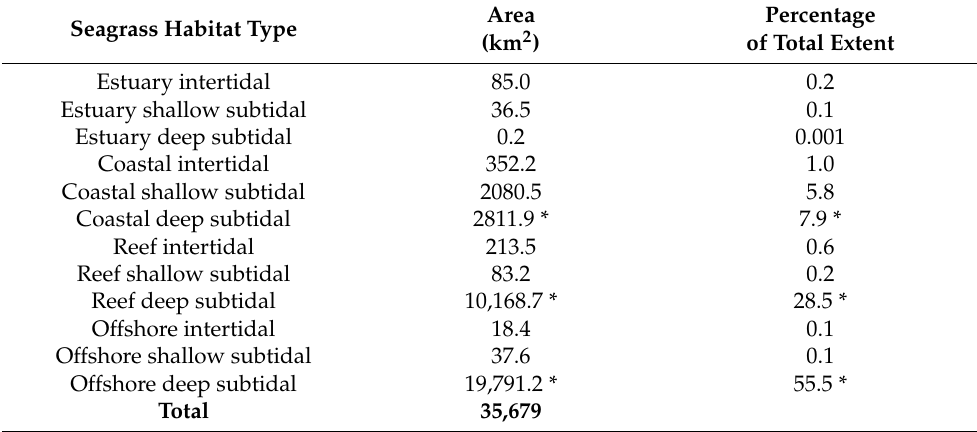
Table 1. Seagrass habitats of the GBRWHA and the composite seagrass extent. For seagrass habitat type description, see [25]. Seagrass extent from [7,10,26,27], where * refers to modelled data. Seagrass Habitat Type